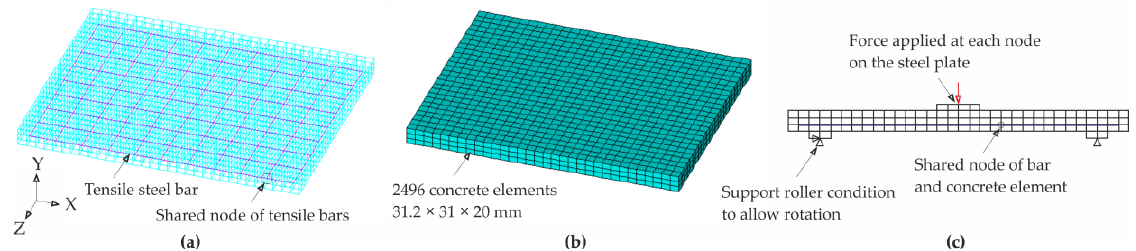
Figure 6. ( a ) Reinforcement configuration; ( b ) slab finite element mesh; ( c ) boundary conditions.